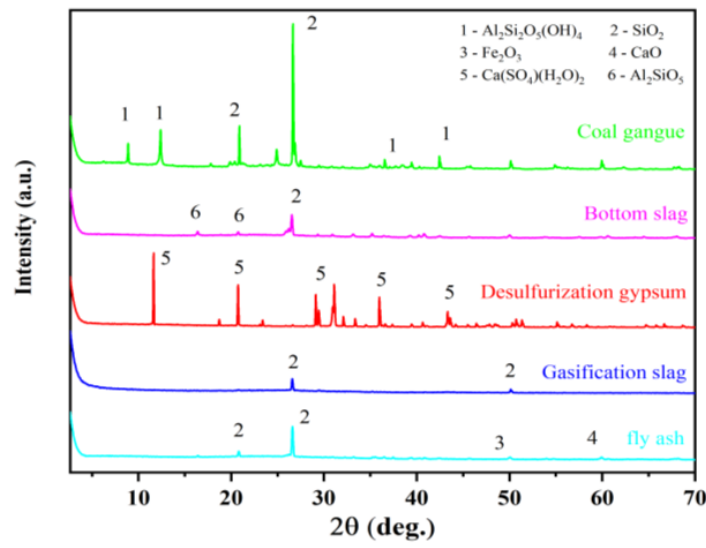
Figure 4. X-ray diffraction (XRD) of coal-based solid waste filling material. Through the scanning electron microscope (SEM) on six kinds of experimental material microstructure tests, as shown in Figure 5, the gangue microscopic form is mainly a block, flake and other irregular forms. This irregular block form resting on the plane does not easily flow, the gangue large particle structure formed for the maintenance of the initial specimen provides a certain strength, and in the late maintenance stage, the generation of crystalline and gel material attached to the gangue and other large particles occurs. The pores are formed by the particles. The large particles of the morphological structure mean that it is easier for it to play its structural role, increasing the compressive strength of the filled specimen. The fly ash microscopic form is more regular, showing spherical particles and these spherical particles are conducive to their own transport and flow; it is easier for them to penetrate the pores between the large particles, increasing the opportunity to react with the cement hydration products, in addition to desulfurization. The microscopic form of gypsum is irregular in size and prismatic block form, and its particle size is moderate and uniform, which makes the particle composition of the mixture more reasonable; the microscopic form of gasification slag is not uniform, and the surface is rough and irregular, and the rough surface increases its specific surface area, which is more conducive to the adhesion of hydration gel and other substances on its surface, thus making the bonding between the particles of the mixture more tight. The microscopic morphology of furnace slag is irregularly lumpy, with obvious sintering traces on the surface, and the microscopic surface is smooth with fine pores, which are conducive to the entry of free water, and the outward migration of free water in the middle and later stages of maintenance is conducive to the continuation of hydration reaction inside the specimen, thus increasing the strength of the specimen. The microscopic morphology of No. 425 ordinary silicate cement is irregularly lumpy, and the particle size is on the high side. The microscopic form of No. 425 ordinary silicate cement is irregularly lumpy, the particle size is small, and the surface is rough, so the tiny particles will enter the pores between the large particles faster and mix with other materials fully in the mixing process so that the hydration product Ca(OH) 2 can react with other components more easily and generate calcium alumina and other crystalline substances, which will increase the strength of the